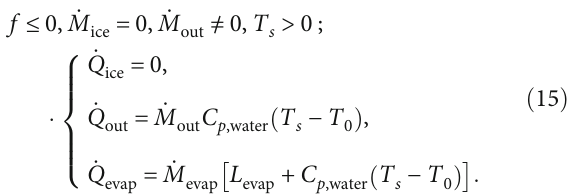
Figure 10: Computation domain and coordinate